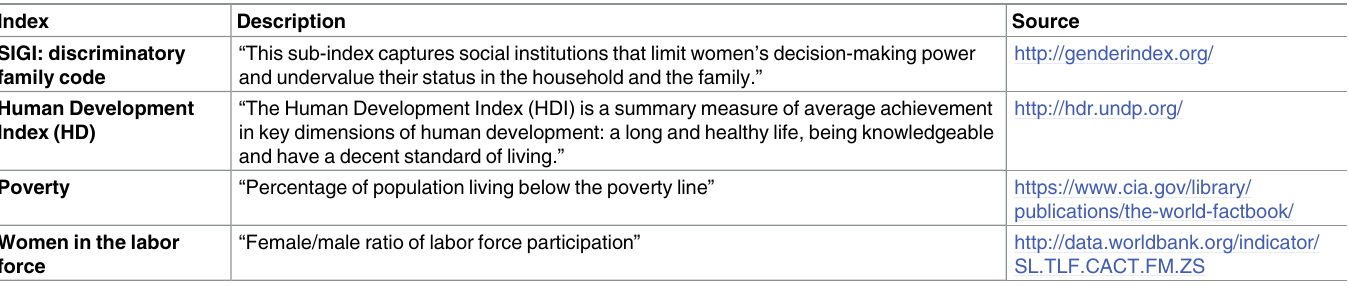
Table 2. Sociocultural country indices examined in the current study.